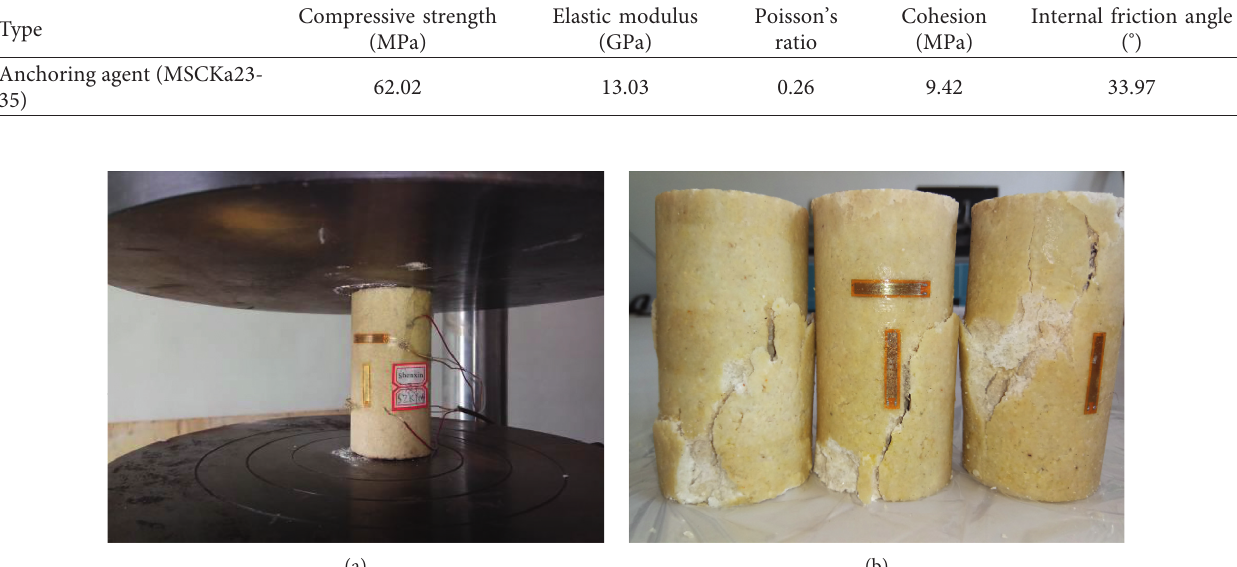
Figure 10: Process of uniaxial compression test and failure specimen. (a) Specimen installation. (b) Failure specimen.